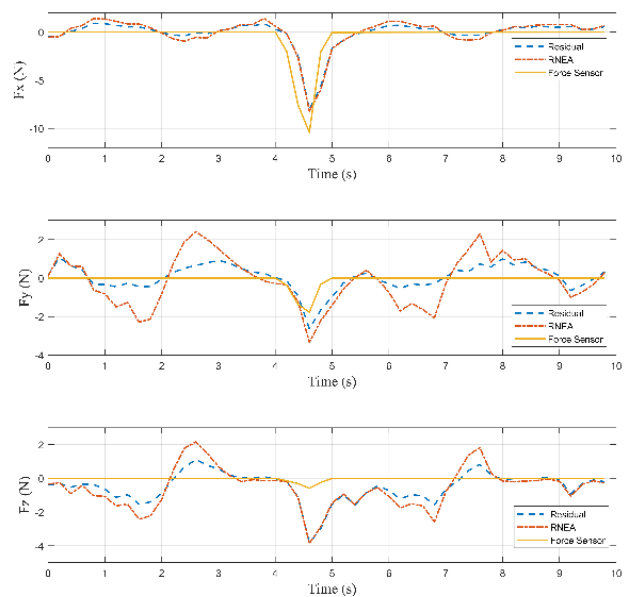
Figure 23. Residuals, the computed forces by RNEA and the force sensors in Case 3. Based on Figure 23, the collision started occurring on the rod at 4.4 s, and the external force was about [ − 2.487 − 0.925 − 1.121 ] T (N). Then, the force reached the maximum value of [ − 8.055 − 2.631 − 3.837 ] T (N) at 4.6 s. According to (39), the root mean square error (RMSE) is applied to evaluate the accuracy of RNEA. RMSE in the X -axis is equal to 1.2268 N, RMSE in the Y -axis is equal to 1.1874 N, and RMSE in the Z -axis is equal to 1.2627